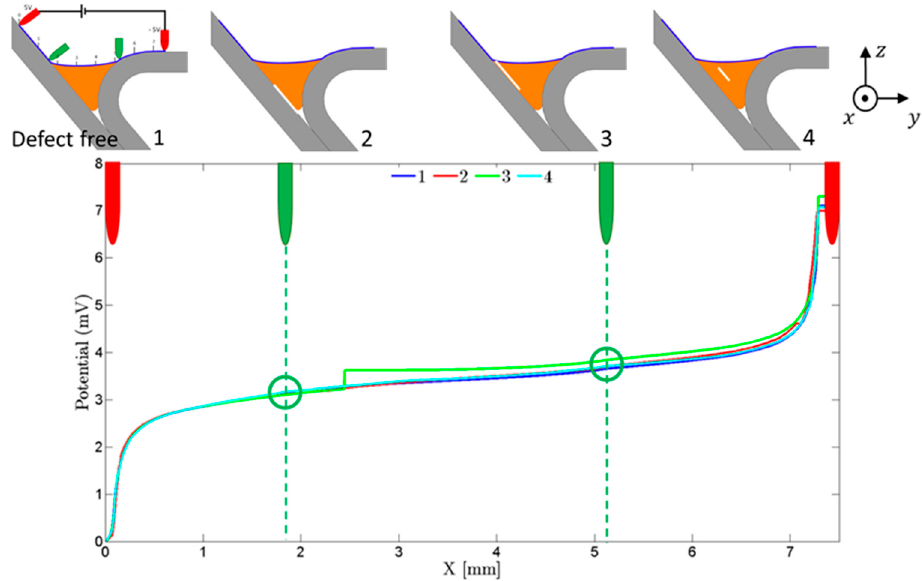
Figure 6. Potential drop along the transversal line that contained all the pins considering four different defects location. The maximum potential drop occurred in the position X ≈ 2.5 mm for the defect type N°3, but the potential drop measured (green pin position) was quite low. ( Legend: 1—No defect; 2—Internal lack of bonding; 3—Surface lack of bonding; 4— Internal weld bead defect).